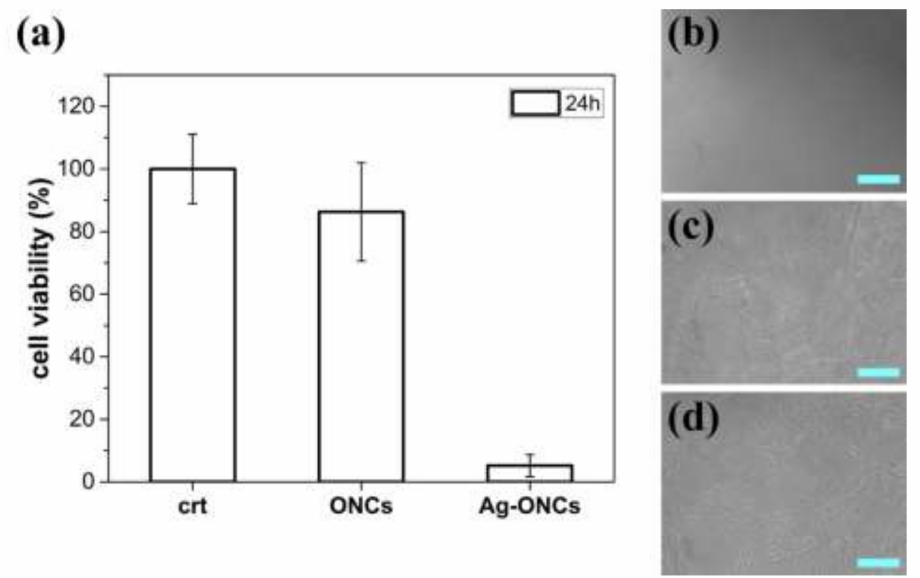
Figure 7. ( a ) Cell viability of NIH-3T3 cells after 24 h of exposure to Ag–ONCs or ONCs and without any NP treatment (crt). Data are presented as mean ± standard deviation (SD). Optical micrographs of NIH-3T3 cells treated with ( b ) Ag–ONCs or ( c ) ONCs and ( d ) without any NP treatment after 24 h of incubation (Scale bar = 100 µ